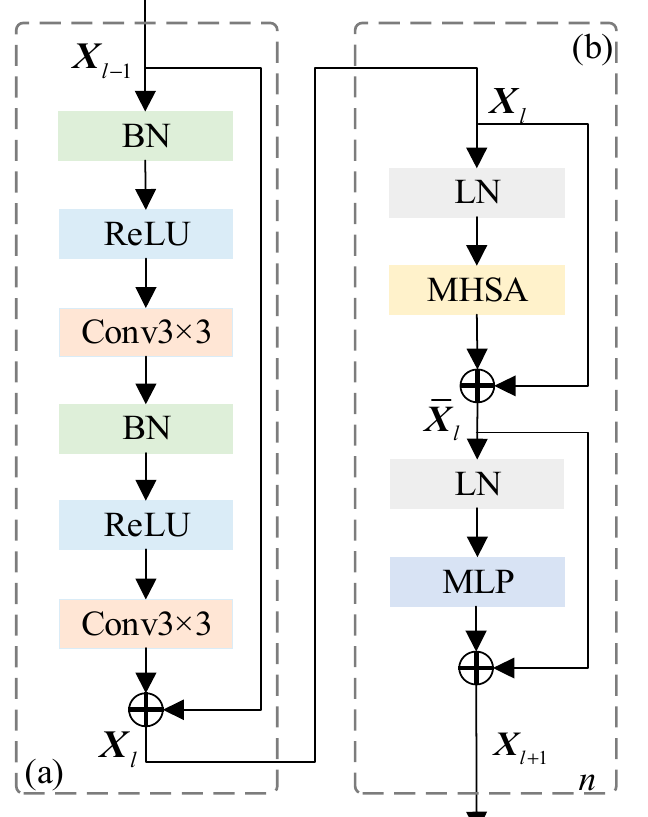
Figure 2. Preactivation-residual block (PR) and transformer block (TB): ( a ) the PR and ( b ) the TB. Problems of false alarm, missed detection, and the loss of details are common in SCD methods and are usually caused by the insufficient ability of the model to extract foreground (region-of-interest) information. Therefore, we introduce the MCFM to handle feature extraction in the foreground and background, as well as globally. While capturing the foreground information, background and global information are supplemented to improve the discrimination of foreground features and obtain more effective edges. As shown in the middle part of Figure 1, we generate difference feature map D i with